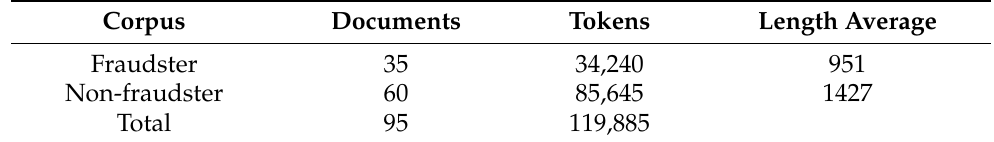
Table 1. Figures describing the corpus used for our experiments in the number of documents, the number of tokens (words) and the document length average in tokens